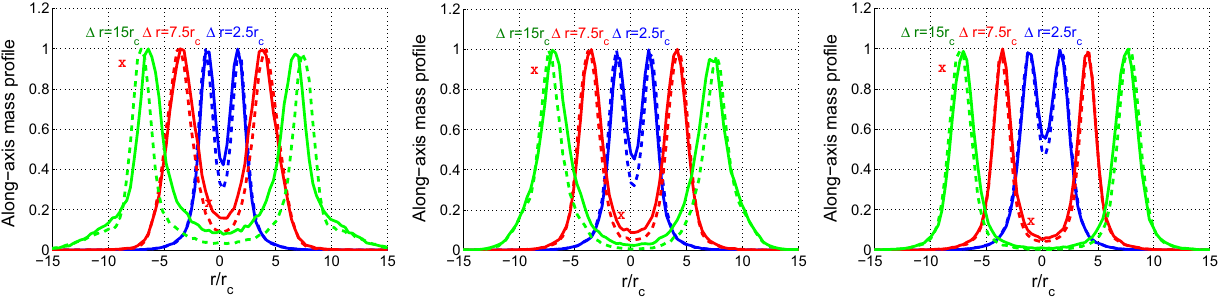
k = 1 . 5 ( left ), k = 2 . 0 ( center ) and k = 4 . 0 ( right ). The differences between interacting DM and CDM models focused upon in the main text are shown with the symbol “ X ”. The CDM halos were first plotted at a fixed separation, and then the SIDM halos were plotted at the same post-collision time, in order to show the offsets between the centroids of the CDM and SIDM halos in galaxy cluster collisions Figure 8 shows such a projected mass distribution plotted against the collision-axial line. At early separation stages, we see that the difference in the projected mass density